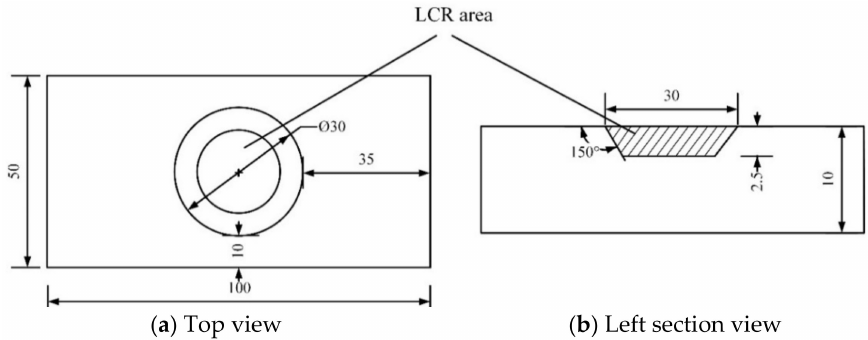
Figure 1. Schematics of the top and left-hand side views of the flat specimens. Table 1. Chemical compositions of the substrate and powder (mass fraction